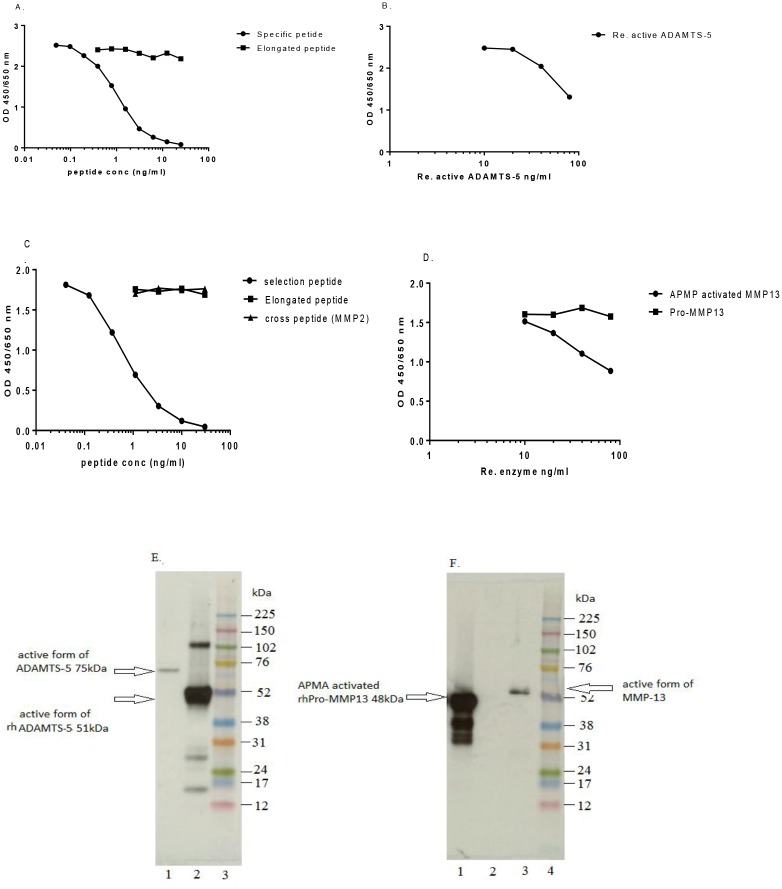
Characterization of active ADAMTS-4 antibody, NB421-13F7, and active MMP-13 antibody, NB469-8C11.(A) The binding of NB421-13F7 to biotinylated peptide was displaced by a specific peptide (SISRARQVEL), but not a elongated peptide (RSISRARQVEL). (B) Displacement of signal with the recombinant human ADAMTS-5 (starting from 80ng/ml to 10ng/ml in2-fold dilution steps) (C) The binding of NB469-8C11 to biotinylated peptide was displaced by a specific peptide (YNVFPRTLKW), but neither a elongated peptide (EYNVFPRTLKW) nor a cross peptide (YNFFPRKPKW, MMP2). (D) Displacement of signal by APMA-activated MMP-13form, but not Pro-MMP13 (starting from 80ng/ml to 10 ng/ml in 2-fold dilution steps). (E) Western blot of active ADAMTS-5 in the supernatant of T+Oinduced bovine cartilage explants (Lane1) and recombinant active ADAMTS-5(Ser262-Pro622) (Lane2). (F)Western Blot of active MMP-13 in APMA-activated recombinant of MMP-13 (Lane1) and the supernatant of T+O induced bovine cartilage explants, but not, recombinant Pro-MMP13 (Lane 2).